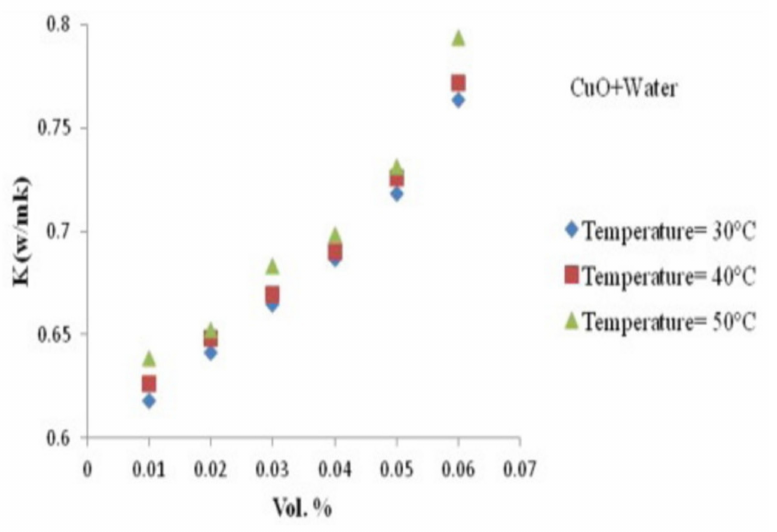
Figure 13. The influence of nanoparticle concentrations on thermal conductivity [189] © Elsevier,